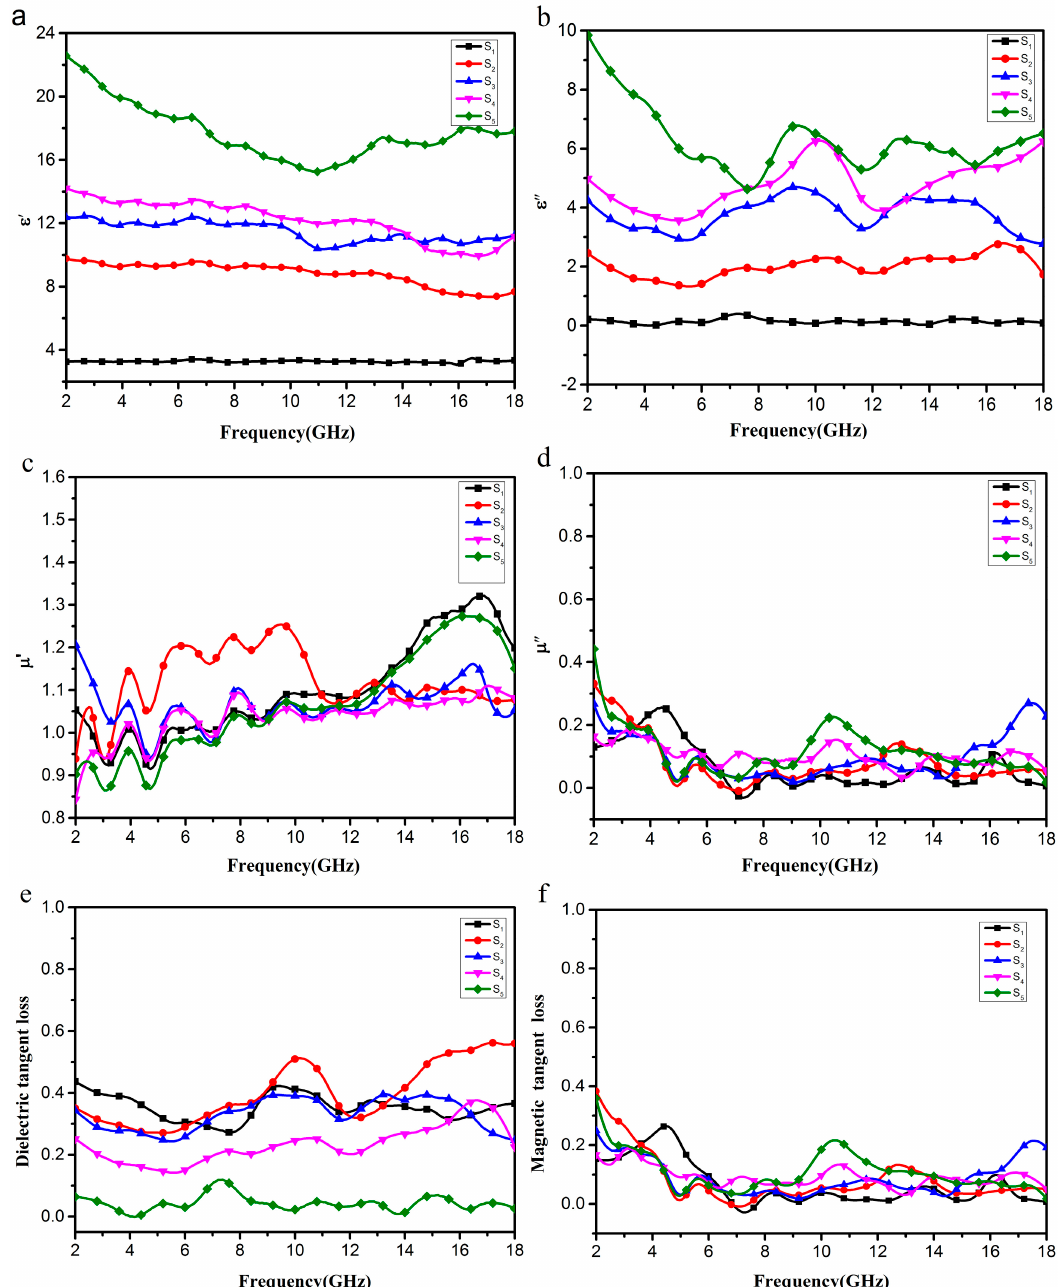
Figure 9. Frequency dependence on real parts ( a ) and imaginary parts ( b ) of the complex permittivity, real parts ( c ) and imaginary parts ( d ) of the complex permeability, and the corresponding dielectric loss tangents ( e ) and magnetic loss tangents ( f ) of composites